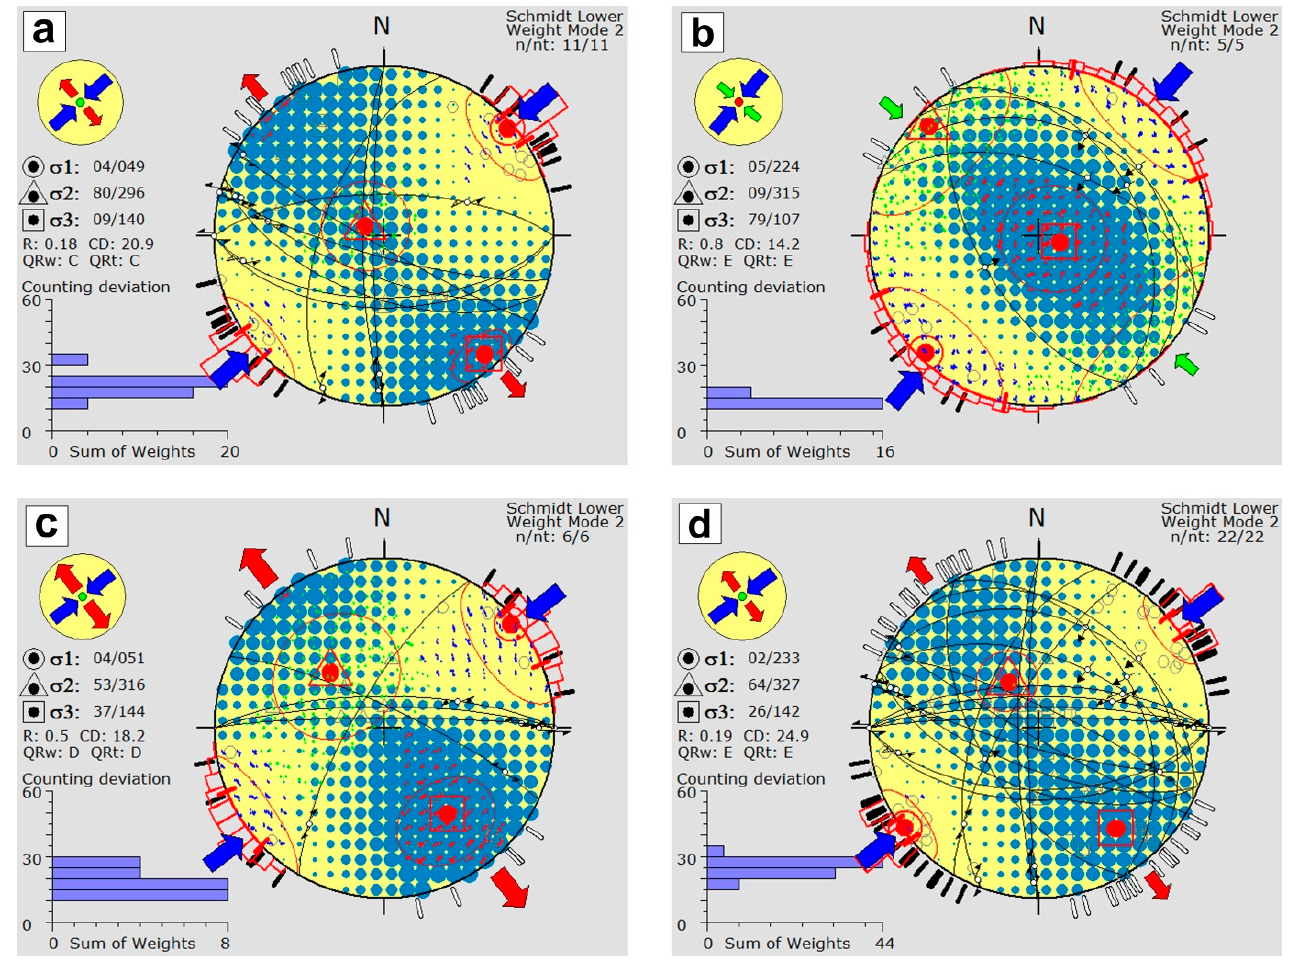
Figure 15. Stress inversion results of the fault slip data implemented by the Win-Tensor program for the western Birjand splay ( a ), eastern Birjand splay ( b ), Shekarab mountains ( c ), and the entire study area ( d ). Table 2. The azimuth (az) and plunge (pl) of the main principal stress axes, computed from the fault slip data ( σ 1 , σ 2 , σ 3 ) for the study area. Senses IS, ID, IX are inverse sinistral, inverse dextral, and pure reverse dip-slip, respectively.